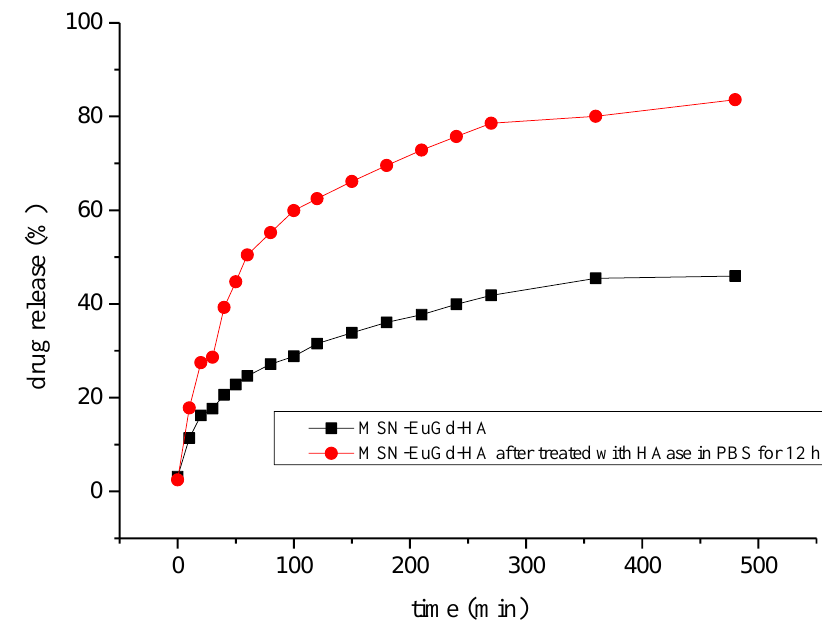
Figure 3. Drug release of MSN-EuGd@CPT-HA and HAase-treated MSN-EuGd@CPT-HA in Dimethyl sulfoxide (DMSO).